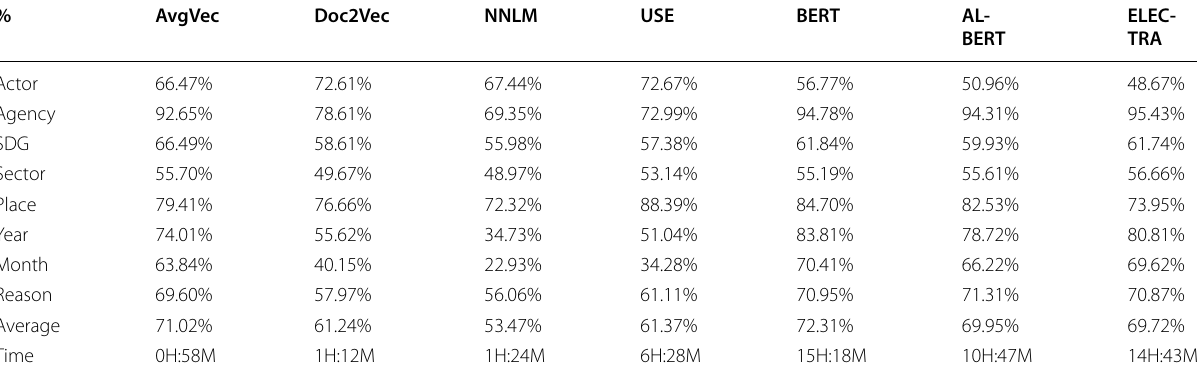
Table 1 Model accuracy using different embedding techniques